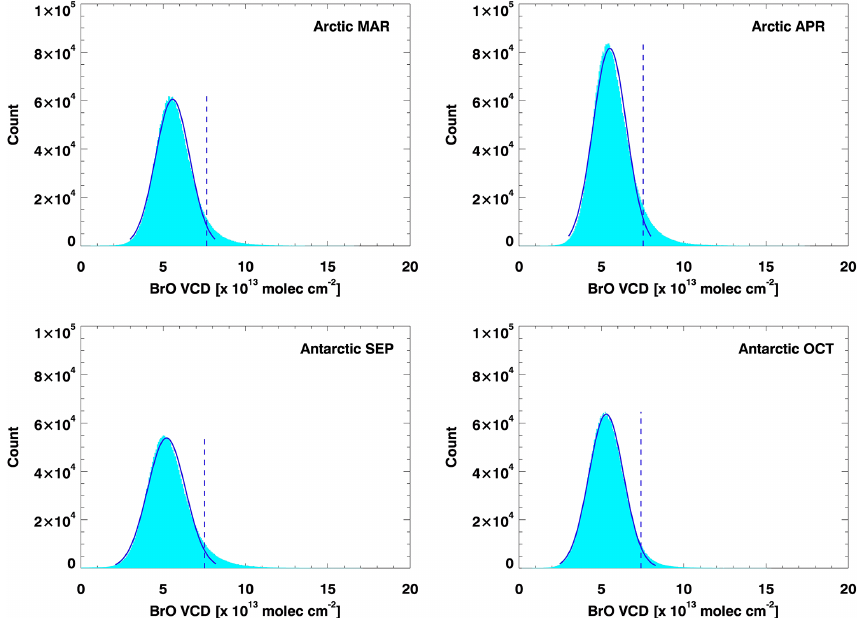
Figure 1. Monthly histograms of the total BrO VCD from GOME-2 measurements during the study period of 2008–2018 (March and April for the Arctic; September and October for the Antarctic). The solid blue line is a fitted Gaussian distribution and the dashed blue line indicates a range of mode + 2 σ (used as the monthly threshold for classifying cases of enhanced BrO columns) for the Gaussian